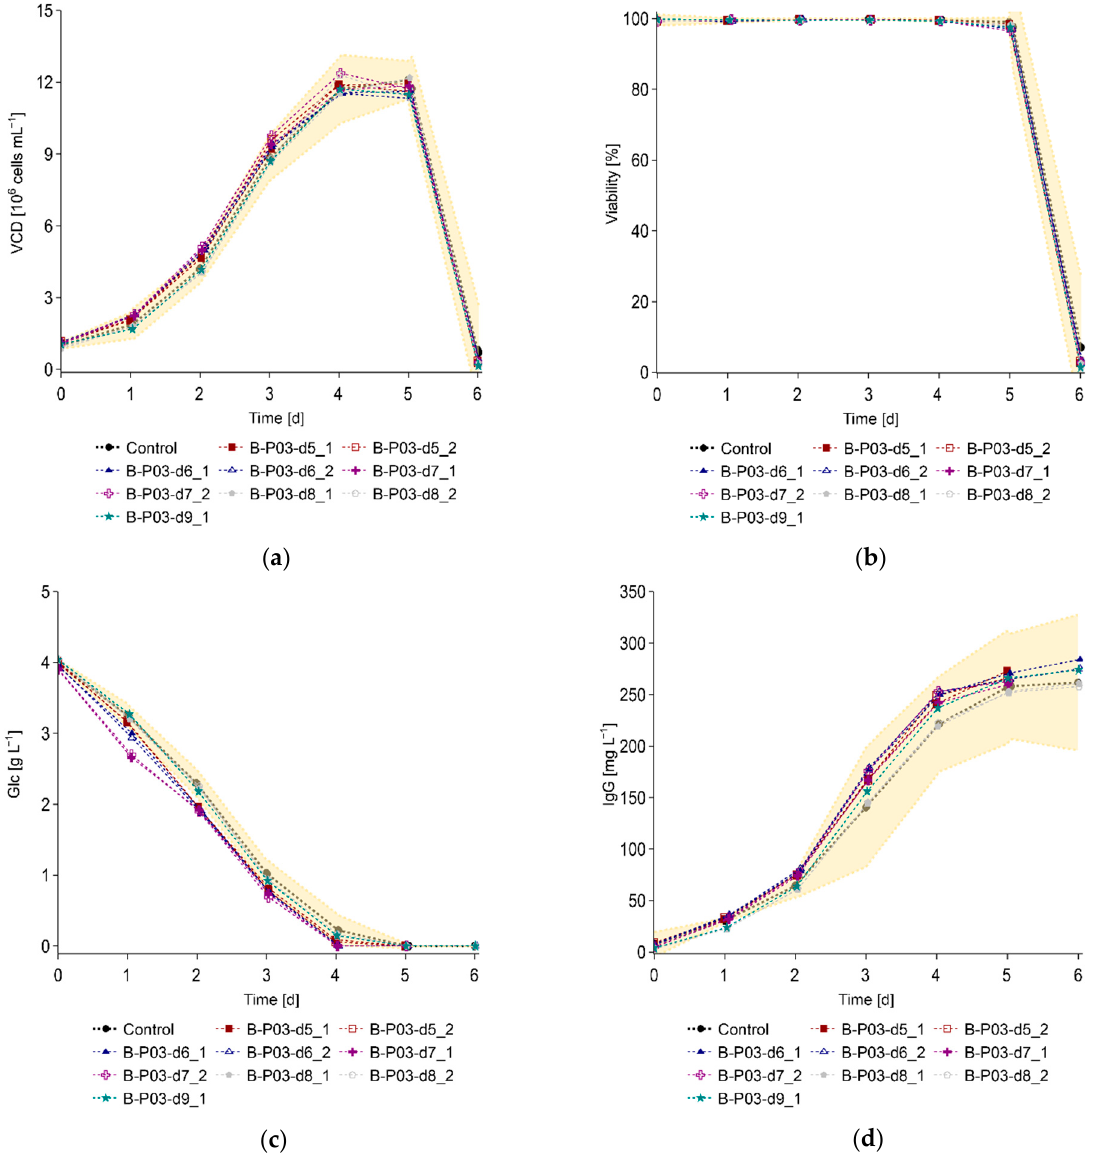
Figure 6. Course of ( a ) VCD, ( b ) viability, ( c ) glucose (Glc), and ( d ) IgG concentration during the batch experiments inoculated from perfusion cultivation (nomenclature: B = Batch, P03 = Source of inoculum, d5–d9 = day of cell harvest from P03). Control: batch experiments inoculated from P03 on days 3 and 4 ( n = 4).